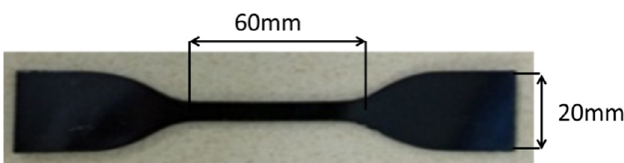
Figure 4. Quasi-static tensile specimens.